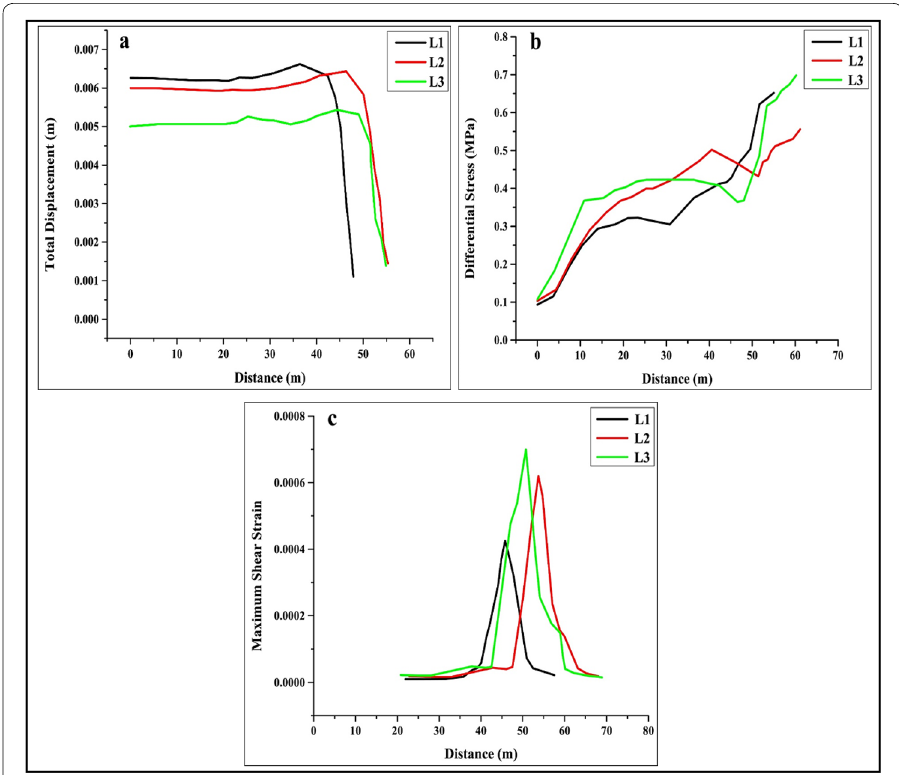
Fig. 6 a Total displacement vs. distance; b differential stress vs. distance; and c maximum shear strain vs.